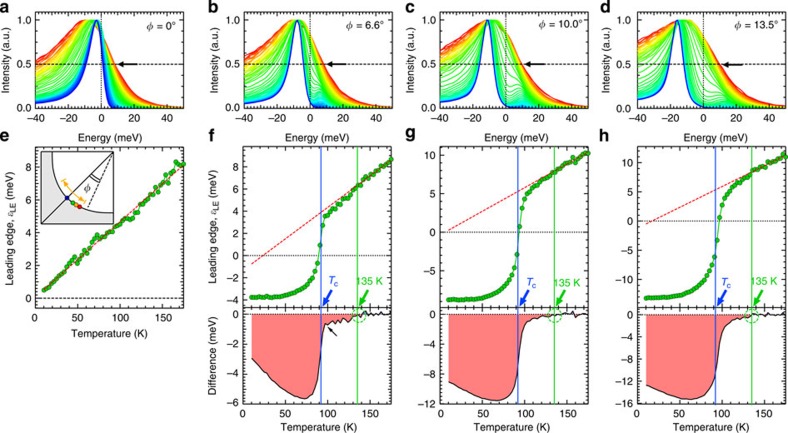
Evidence for the point nodal gap surviving above Tc revealed by means of the energy shift of spectral leading edge.(a) The temperature evolution of ARPES spectra (EDCs) at the gap node for OP92K, normalized to the peak intensity of each curve. (b–d) The same spectra as a, but measured off the node (colour circles in the inset of e). (e–h) Temperature dependence of the spectral leading edge, ɛLE(T), defined as energies where the spectral peaks become half in intensity (marked by arrows in a–d). The bottom panels of f–h plot the difference of ɛLE(T) from the T-linear behaviours (red dashed lines), which are fit to ɛLE(T) at high temperatures. The onset temperatures of the deviation from T-linear behaviour are around 135 K for all the kF points off the node (dashed circles). A kink is seen in the difference curve for f (small black arrow) because the thermally populated Bogoliubov peaks in the unoccupied side significantly affect the shapes of leading edge specially at kFs close to the node with small gaps. The inset of e shows the Fermi surface with the examined kF points. The bold orange arrow indicates the momentum region where the Fermi arc was previously claimed to emerge at Tc.